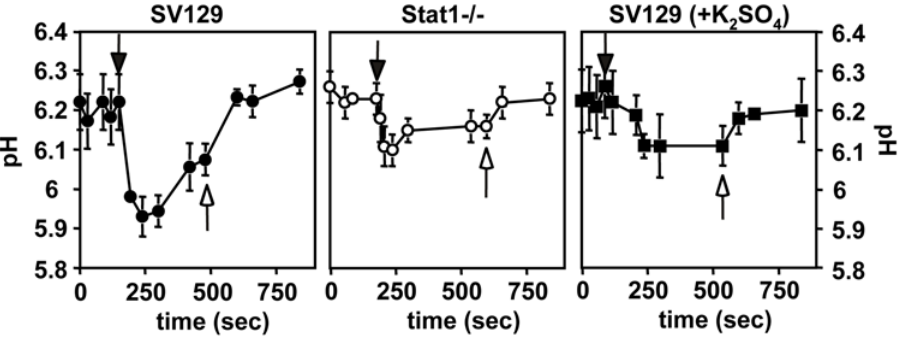
Figure 5. pH measurement on isolated phagosomes. Intra-vesicular pH of phagosomes containing FITC-labeled zymosan was determined in untreated control preparations (left panel), untreated preparations from Stat1 2 / 2 BMMs (middle panel), and control preparations treated with 93 mM K 2 SO 4 (right panel). Acidification was initiated by addition of 2.5 mM ATP and 1 mM MgSO 4 (closed arrow). Subsequent addition of 20 m M NH 4 Cl increased the pH of all phagosome preparations (open arrow). The addition of 10 m M nigericin increased the pH to 7 (not shown). Each time course was done in triplicate with the standard deviation indicated by the error bars.